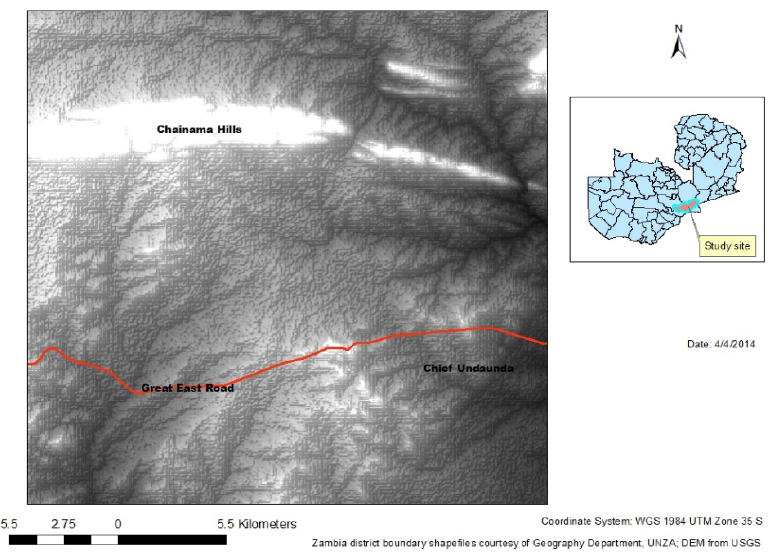
Figure 5. Location of study